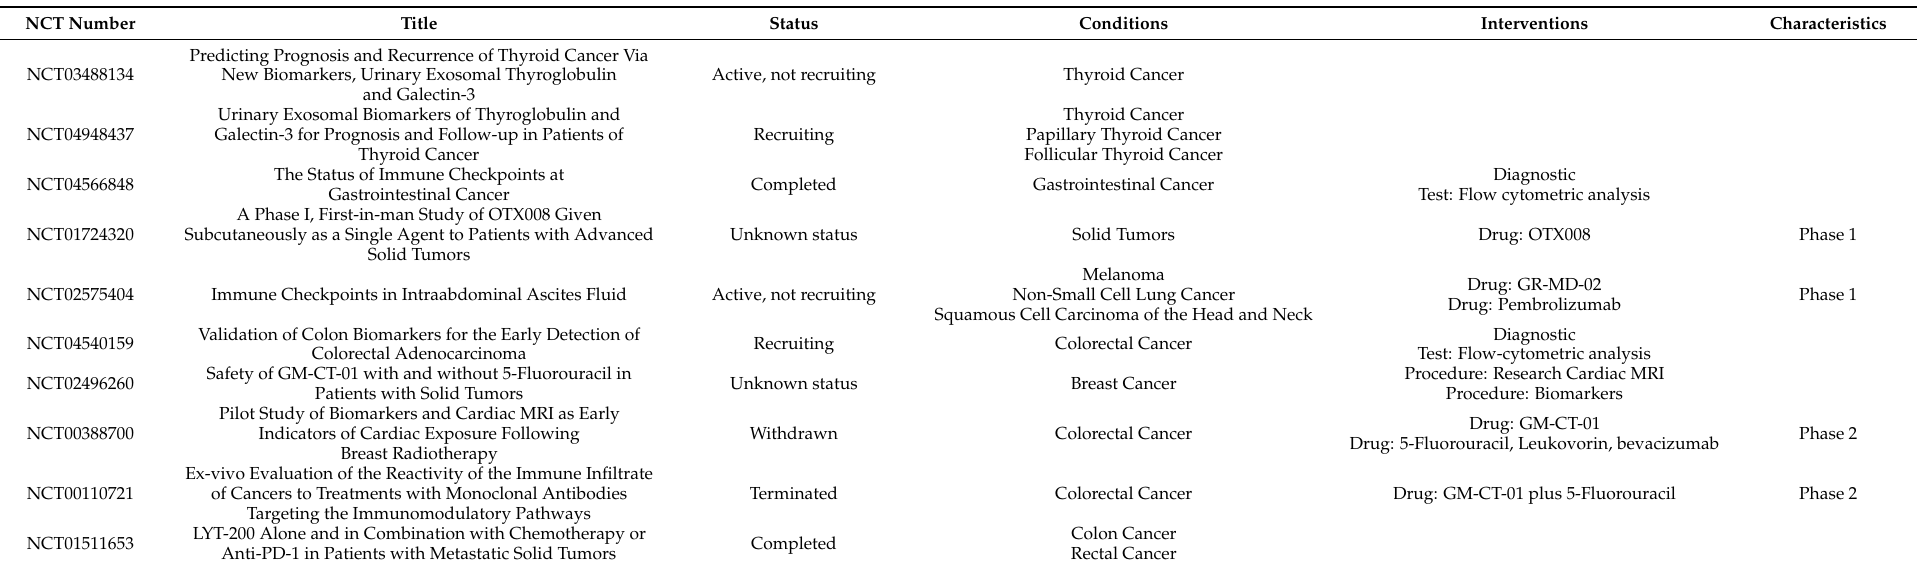
Table 2. Galectins are used in various clinical trials for solid cancer